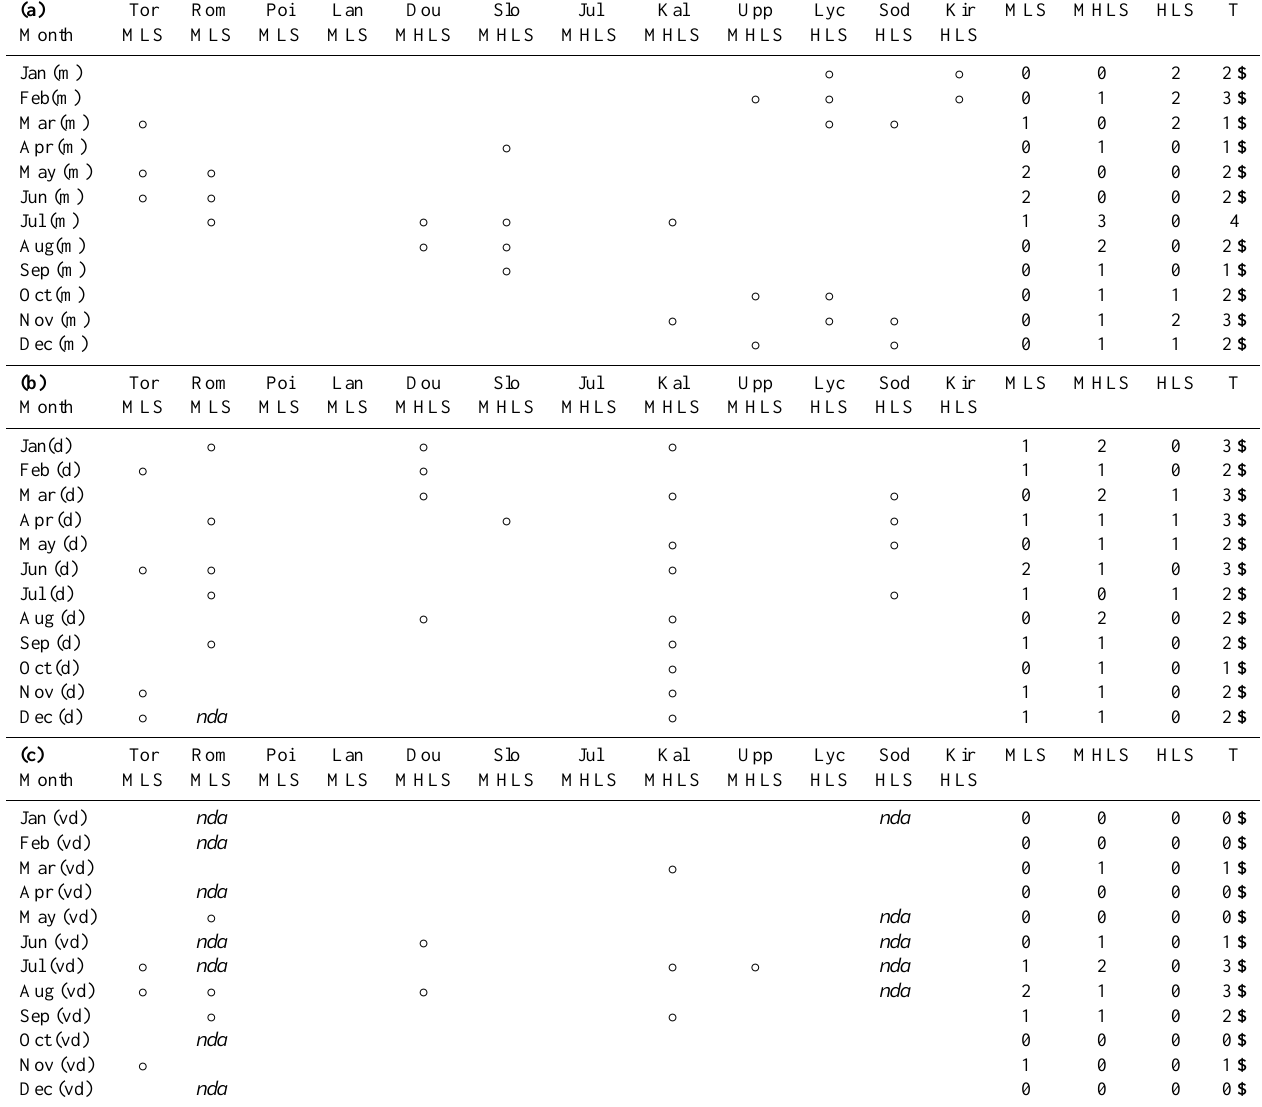
Table 4. Same as Table 2 but for the sites where the best performance is provided by the IRI model, indicated with the empty circle. The term nda indicates the cases for which it was not possible to evaluate the performance of the IRI model with respect to the other models because no data were available to calculate the g.r.m.s.